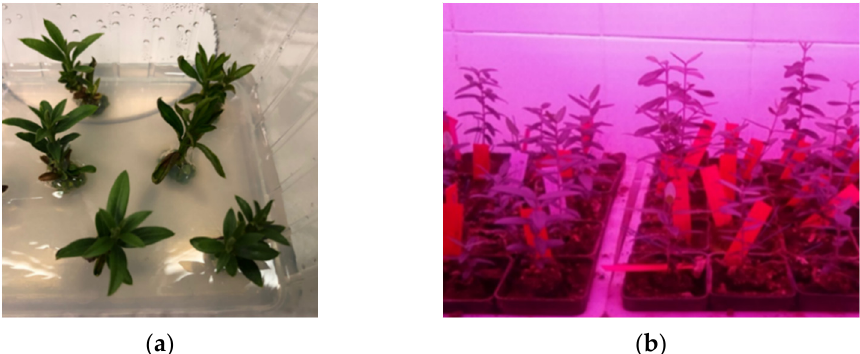
Figure 3. ( a ) In vitro olive plantlets in the multiplication step; ( b ) plantlets developed from isolated